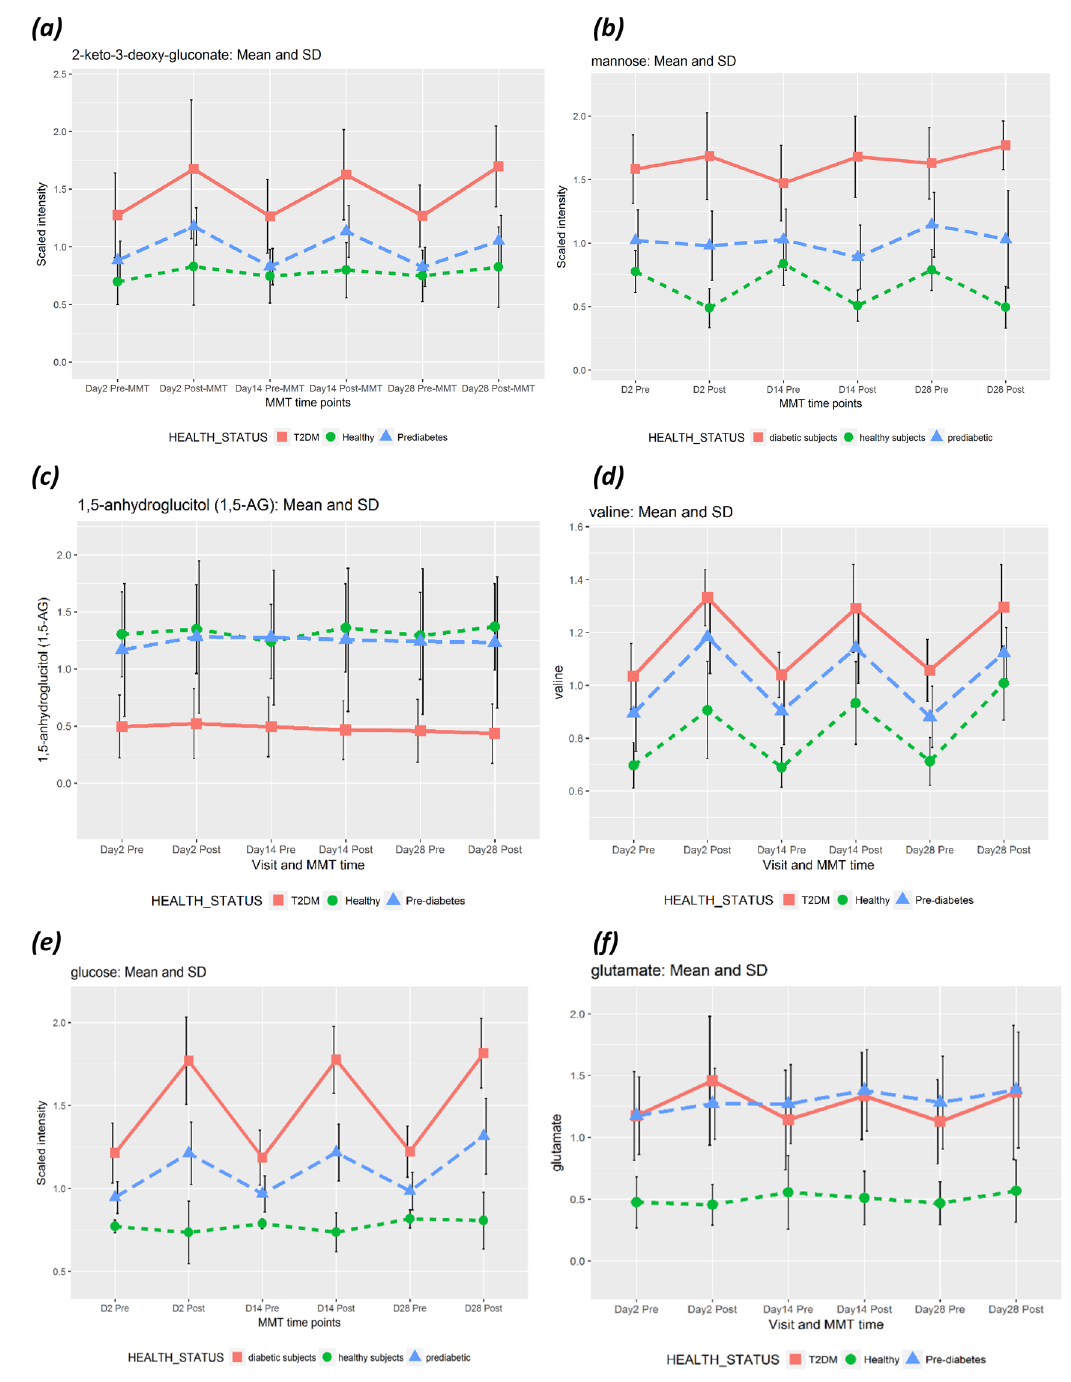
Figure 8. Selected metabolites differing between health groups before the mixed-meal test. Diagrams show mean metabolite levels per health group ± SD for study days 2, 14 and 28, pre- and post-MMTT for ( a ) 2-keto-3- deoxy-gluconate, ( b ) mannose, ( c ) 1,5-anhydroglucitol, ( d ) valine, ( i ) glucose and ( f )